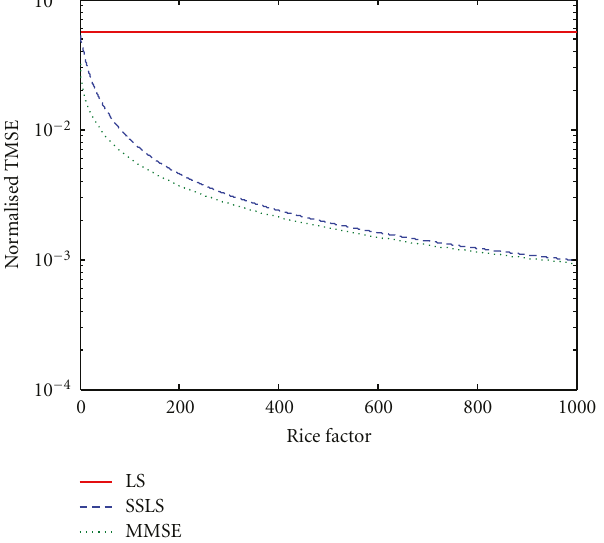
Figure 10: Normalized TMSE of the LS, SSLS, and MMSE estimators versus Rice factor for SNR = 10 dB, N T = N R = 4, L = 8, N P = 72 .